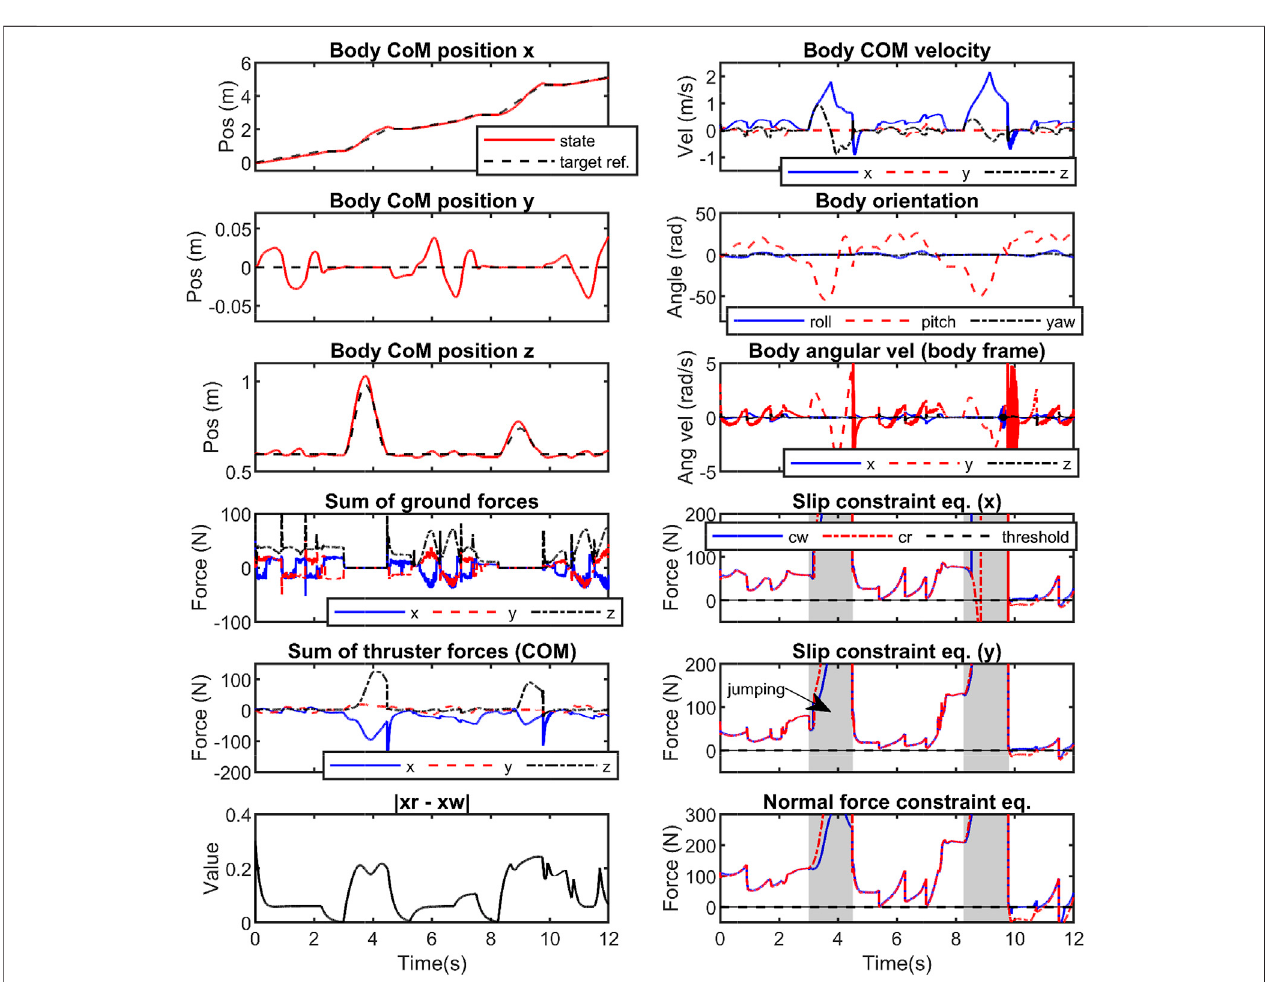
FIGURE8| Illustration ofthruster-assisted locomotion over aroughterrain simulatedon Harpy ’ sfull-dynamics. Blueand red arrows show thethrusteractions and GRF, respectively.